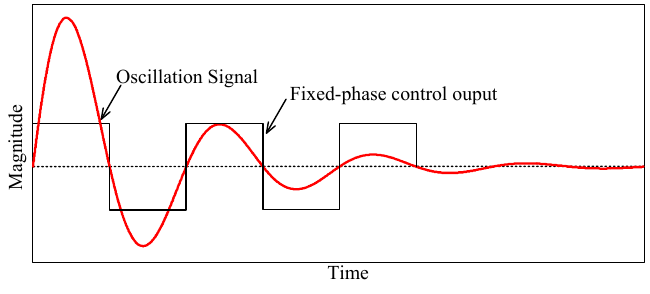
Figure 4. A diagram of the fixed-phase damping controller.